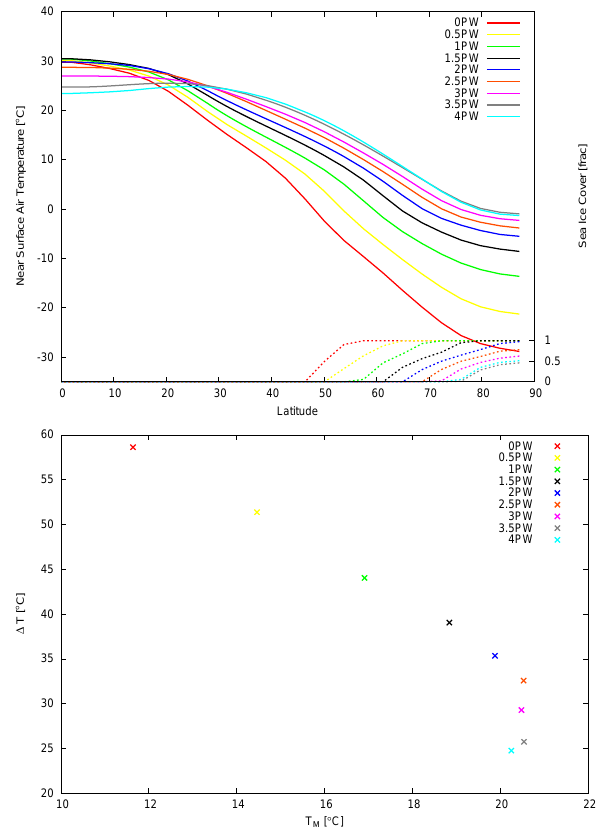
Figure 2. Climatological annual averages for all simulations. Up- per panel: zonal mean near-surface temperature (solid lines) and sea-ice cover (dotted lines). Lower panel: global mean near-surface temperatures ( T M , in ◦ C) vs. equator-to-pole gradient ( (cid:49)T , in ◦ C).